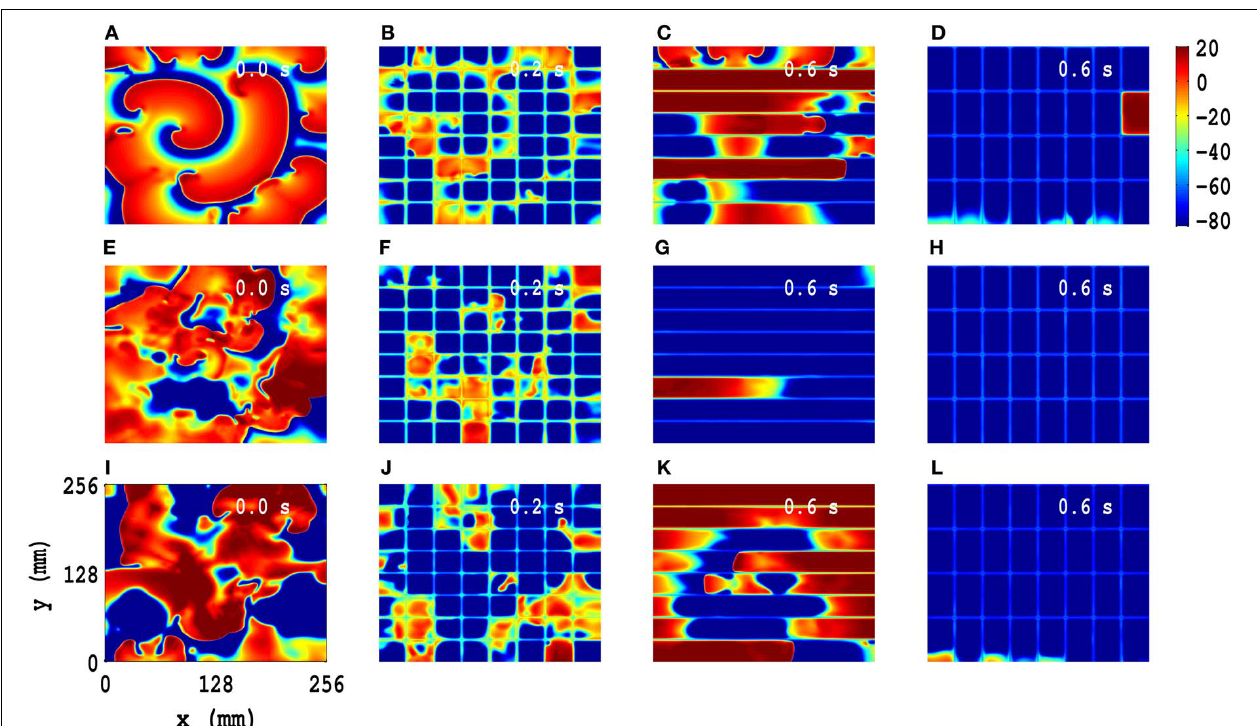
with each square block of side l = 32mm; amplitude 125pA/pF for t = 0 . 6s over a line mesh (C,G,K) , with inter-line spacing l = 32mm; amplitude 125pA/pF for t = 0 . 6s over a rectangular mesh (D,H,L) , with block sides l x = 32mm and l y = 64mm. These pseudocolor plots of V m and the associated animations in Video S9 show that these spiral states, with IC 1, IC 2, and IC 3 initial conditions, are suppressed by both square- and rectangular-mesh control but not line-mesh